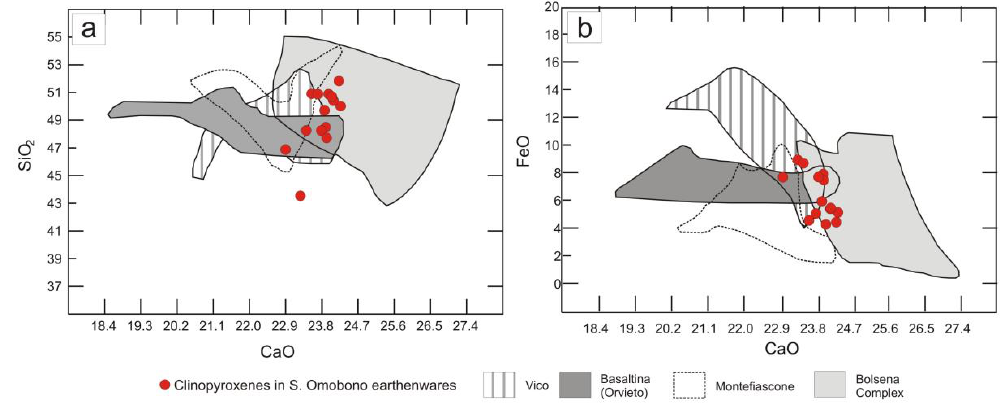
Figure 6. CaO vs SiO 2 ( a ) and CaO vs FeO ( b ) diagrams showing the comparisons between the clinopyroxenes analyzed in the archaeological samples of S. Omobono and those found in some Roman volcanic districts [66].